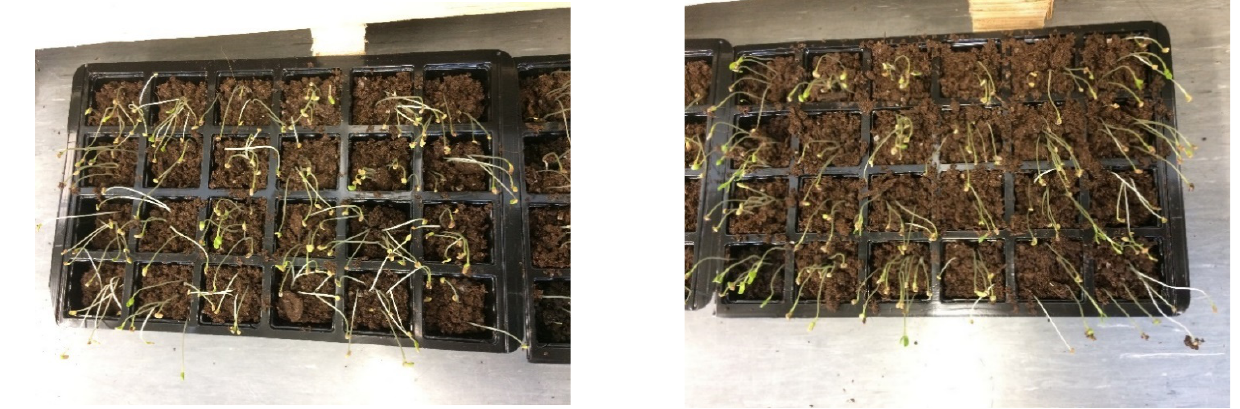
Figure 5. Typical top view after seven days of watercress germination with deionized water. ( Left ) Conventional DI water. ( Right ) With NBs drawn in from air.